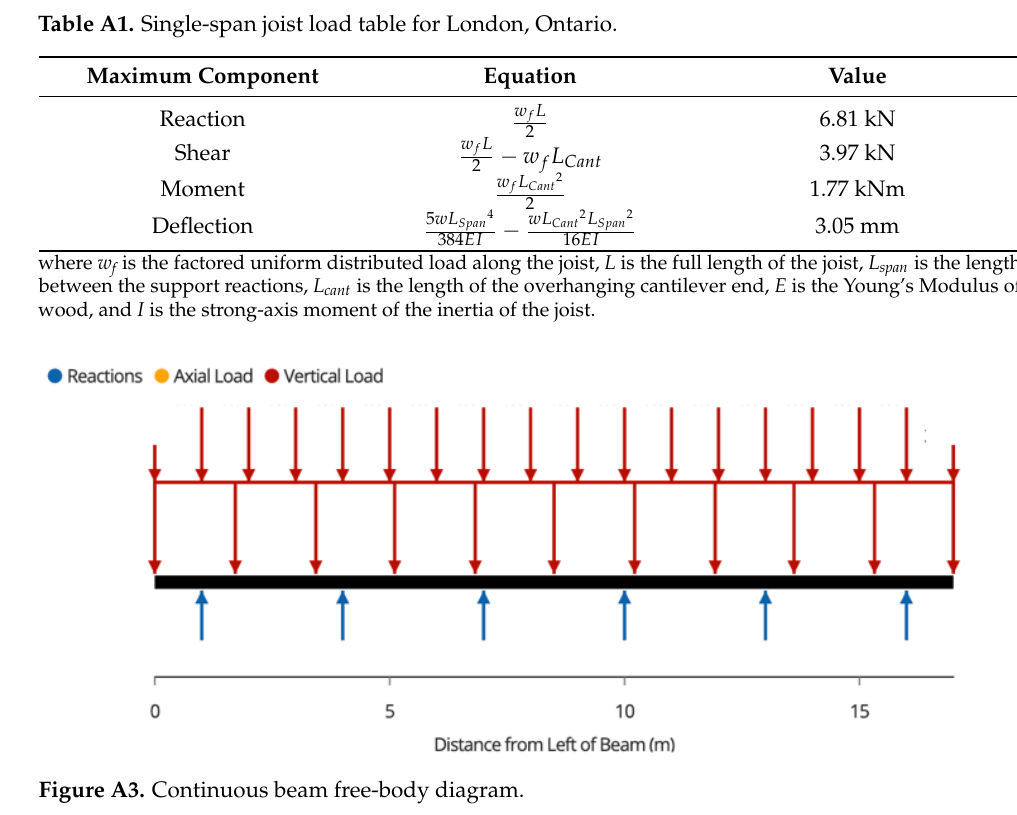
Figure A4. Beam ( a ) shear force diagram, ( b ) bending moment diagram, and ( c ) deflection diagram over the beam length in m. This indeterminate beam can be solved using analytical methods, such as the mo- ment distribution method; however, analytical solutions can be long and tedious. There- fore, we suggest the use of an open-source beam calculator from Clear-Calcs [91] to quickly acquire these values. The results for London, Ontario, are summarized in Table A2. Table A2. Single-span beam load table for London, Ontario. Maximum Component